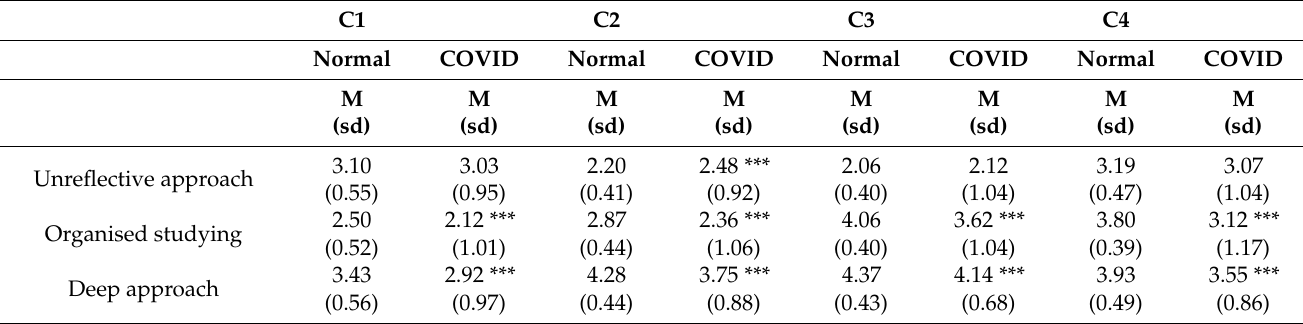
Table 4. The differences in approaches to learning, perceptions of teaching–learning environment and burnout (C1 = unor- ganised and nonreflective students; C2 = deep and unorganised students; C3 = students representing deep approach; and C4 = all high students).